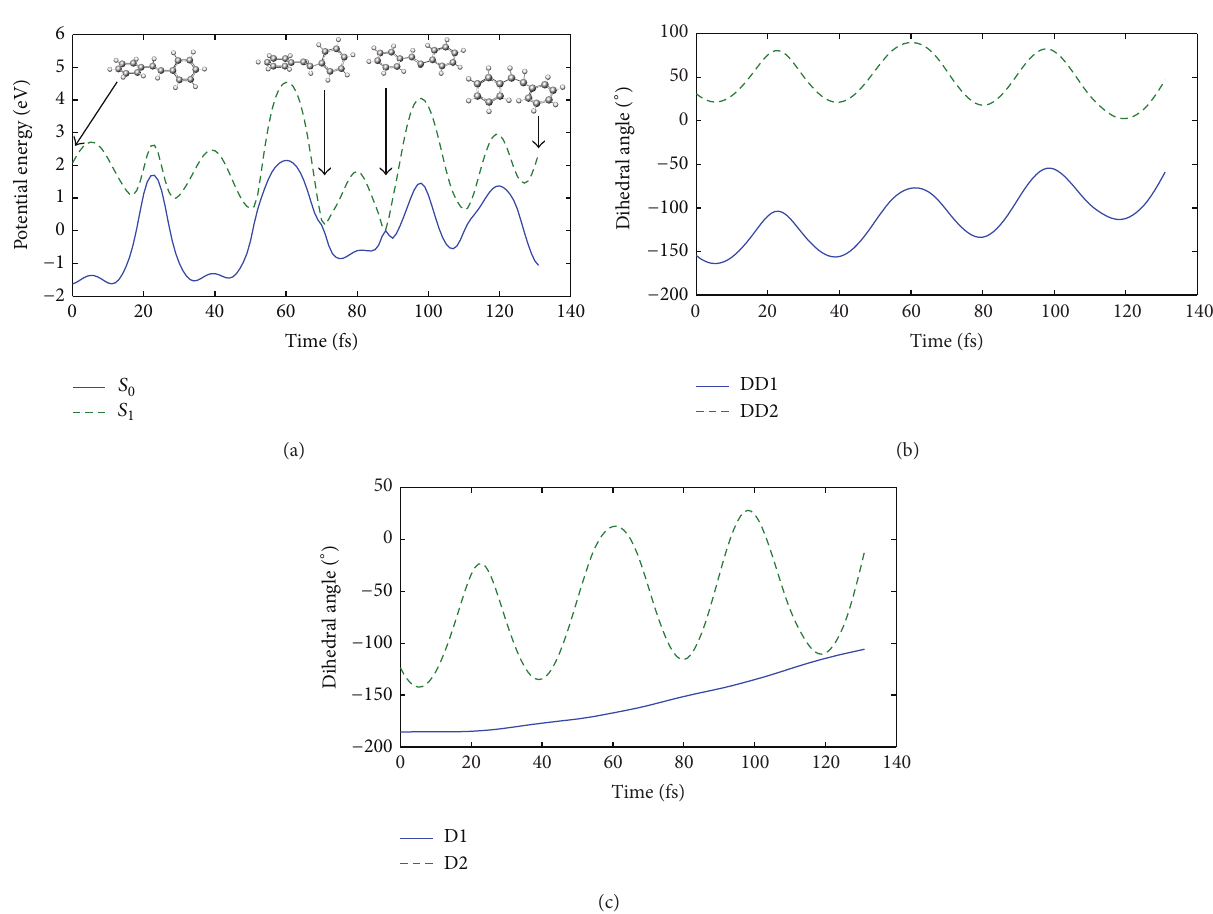
Figure 5: A typical reactive trajectory for trans-to-cis isomerization starts from local trans-area with photo-excitation energy 3.98 eV. (a) Snapshots of potential energy surfaces and structures varying with time, (b) DD1 and DD2, and (c) D1 and D2 varying with time.